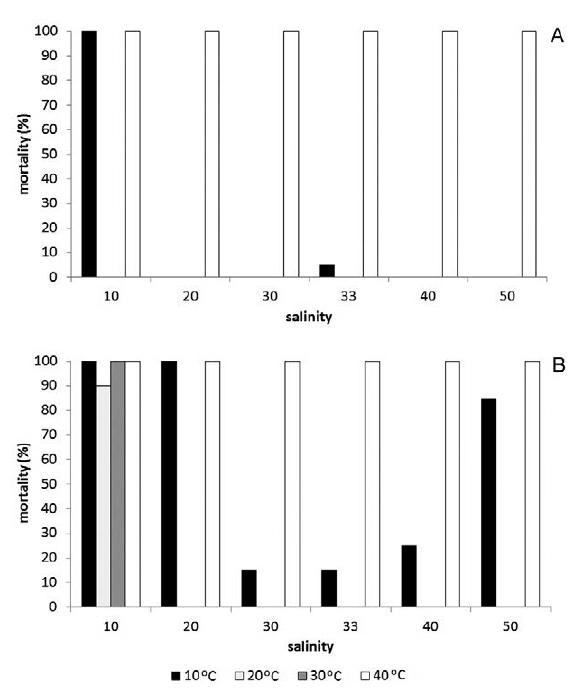
Fig. 3. – Salinity and temperature (°C) tolerance of Polygordius eschaturus after 24 h (A) and 192 h (B) of exposure.